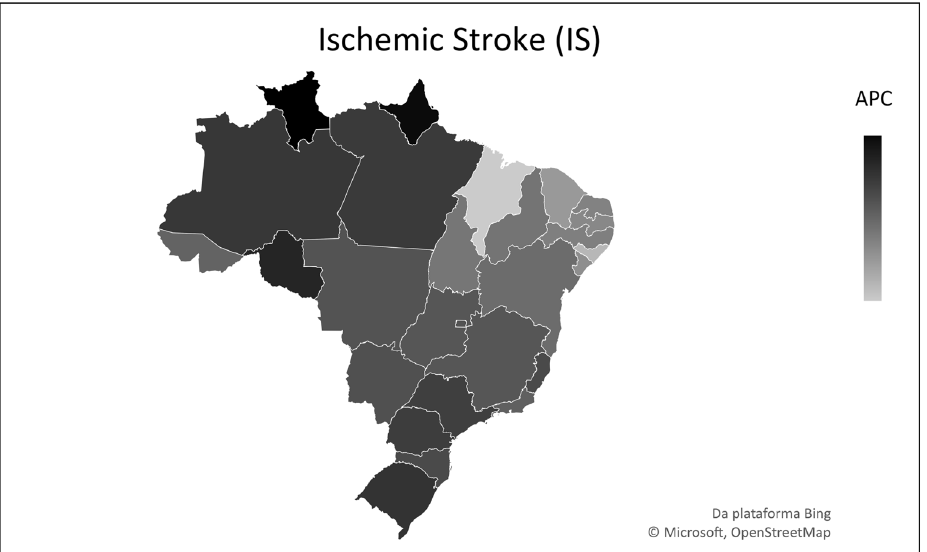
Figure 3. Temporal trend of mortality from childhood ischemic stroke (IS), from 1990–2019, in Brazilian Federative Units. APC annual percentage